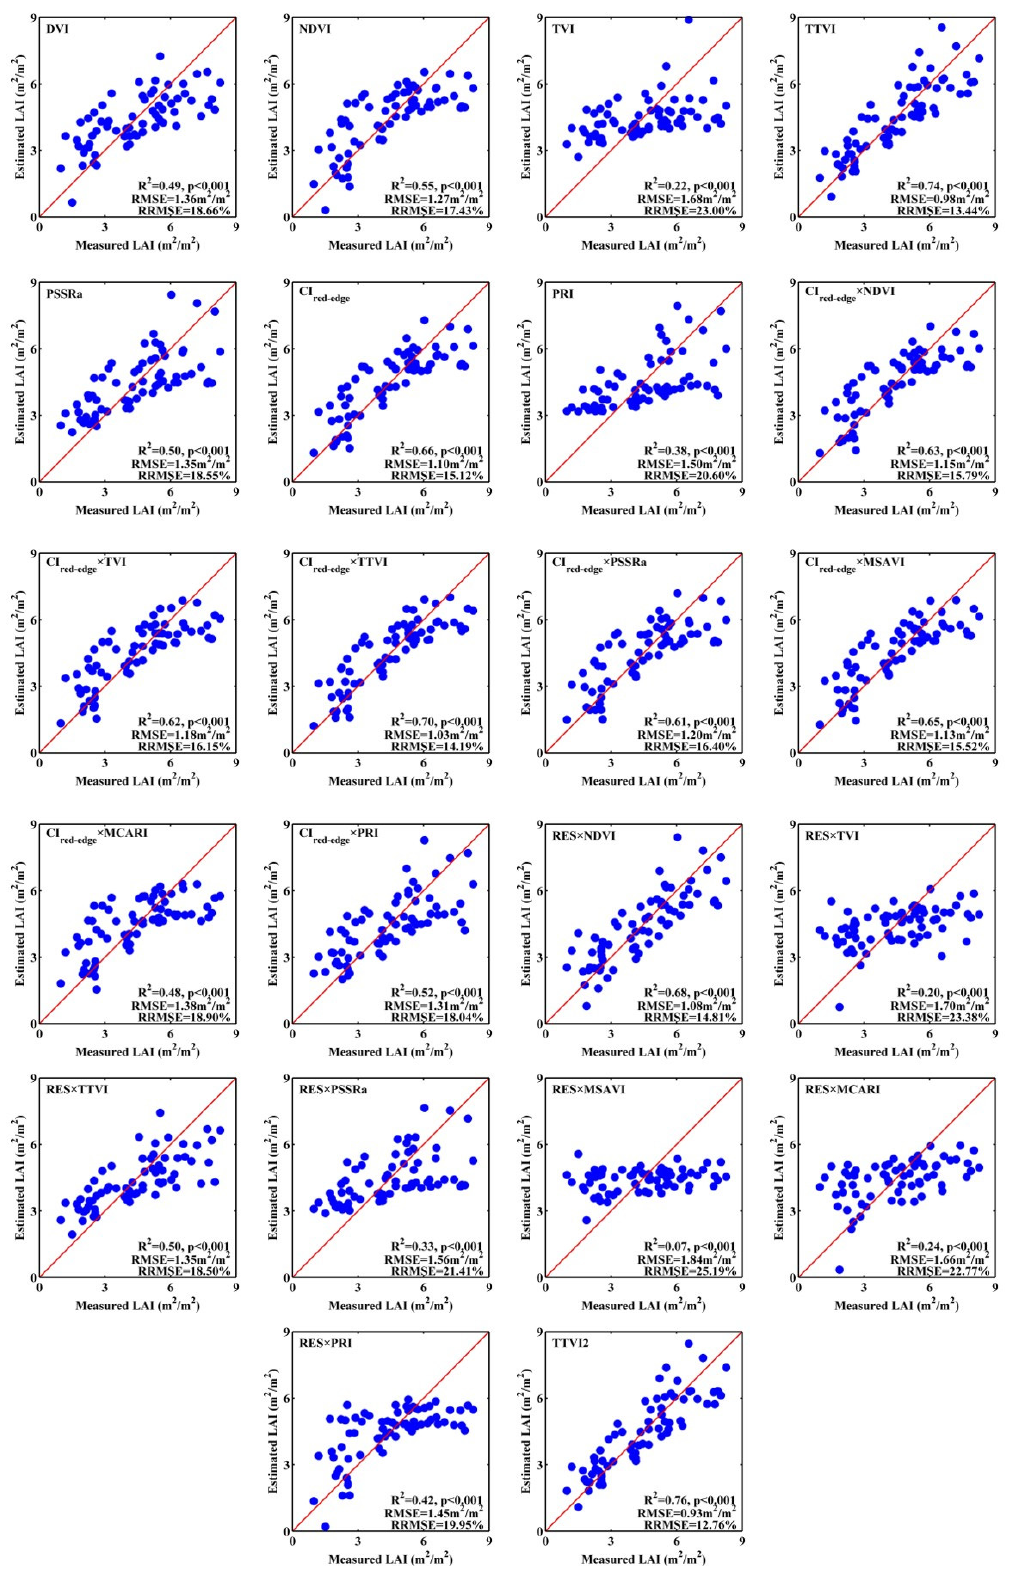
Figure 7. Scatterplots of the measured LAI versus estimated LAI, derived from ground hyperspectral vegetation indices. Red dashed lines indicate the 1:1 line.